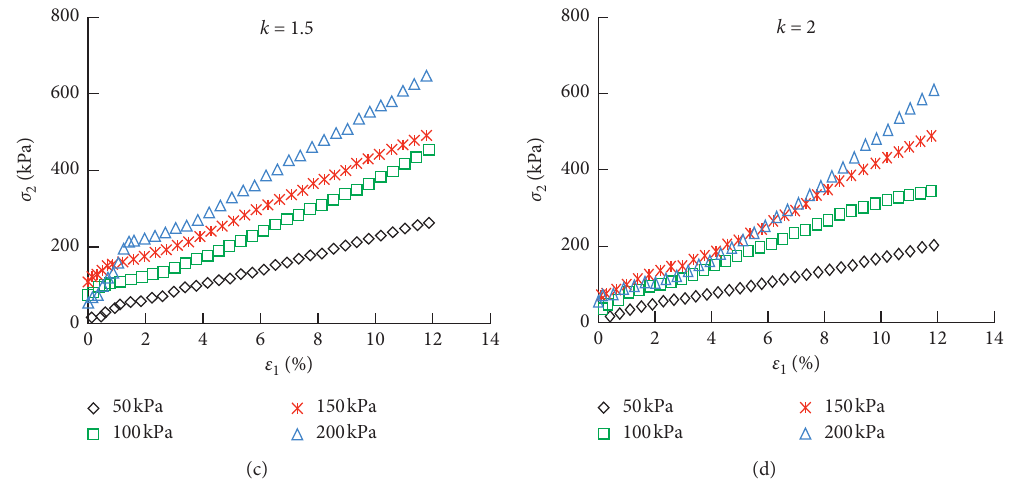
Figure 8: σ ∼ ε curves of intact loess at different confining pressures. 2 1